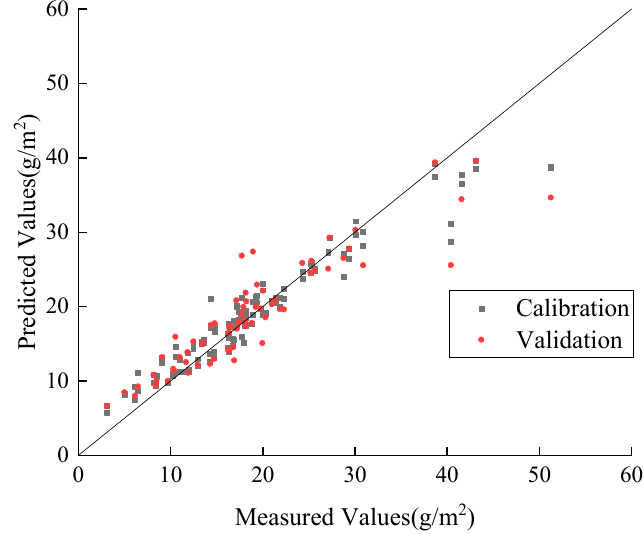
Figure 12. Comparison between measured and estimated values of dust retention content.